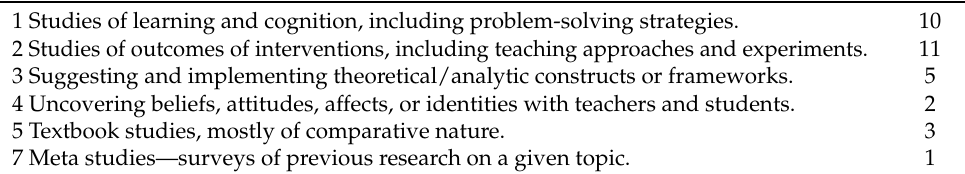
Table 3. Categorisation in research study paradigms of the papers in NORMA17.